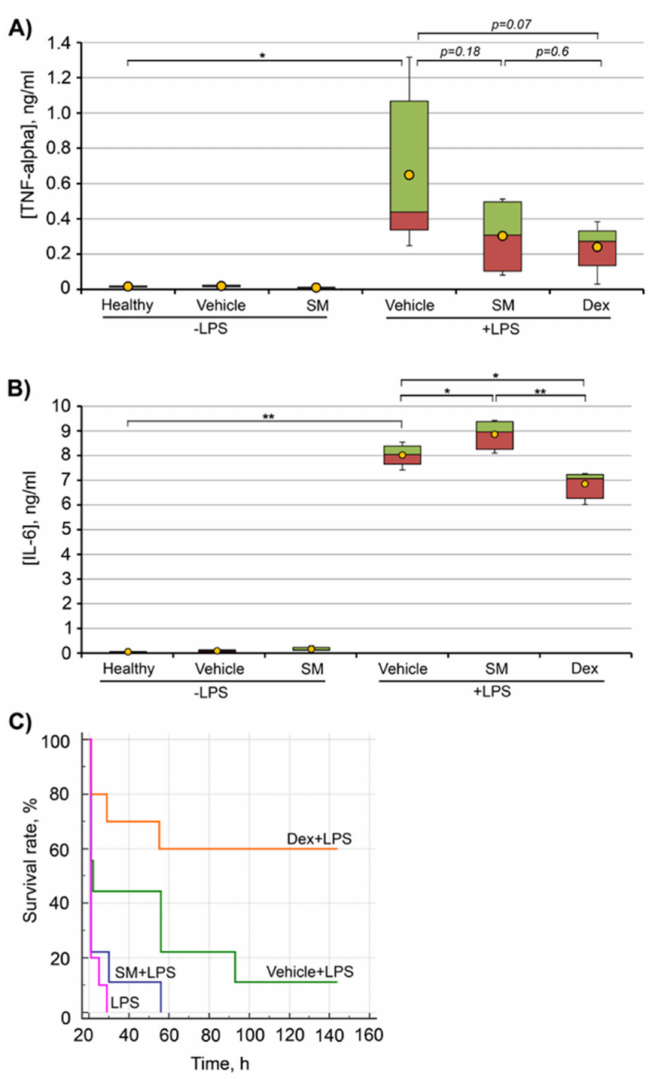
Figure 8. Anti-inflammatory e ff ect of SM on the LPS-induced endotoxemia model. ICR mice were intraperitoneally (i.p.) administered with SM in 10% Tween-80 (vehicle) at a dose of 50 mg / kg 1 h prior to endotoxemia induction by LPS at a dose of 5 mg / kg (non-lethal endotoxemia) or 20 mg / kg (lethal endotoxemia). Pro-inflammatory cytokines TNF- α ( A ) and IL-6 ( B ) were measured by ELISA 4 h after non-lethal endotoxemia induction. Survival rates ( C ) were evaluated after lethal endotoxemia induction. In both experiments, dexamethasone at a dose of 0.5 mg / kg ( A , B ) and 1 mg / kg ( C ) was used as the reference drug. Di ff erences between groups were statistically significant at * p < 0.05 and ** p <